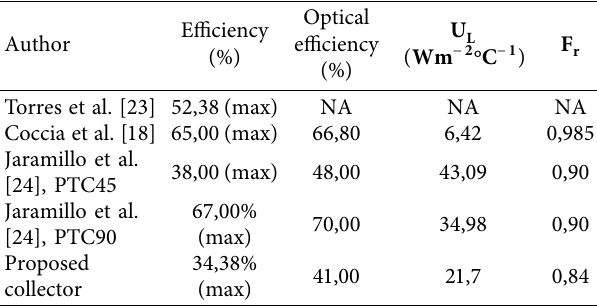
Table 4: Comparison of thermal efficiency among different collectors.